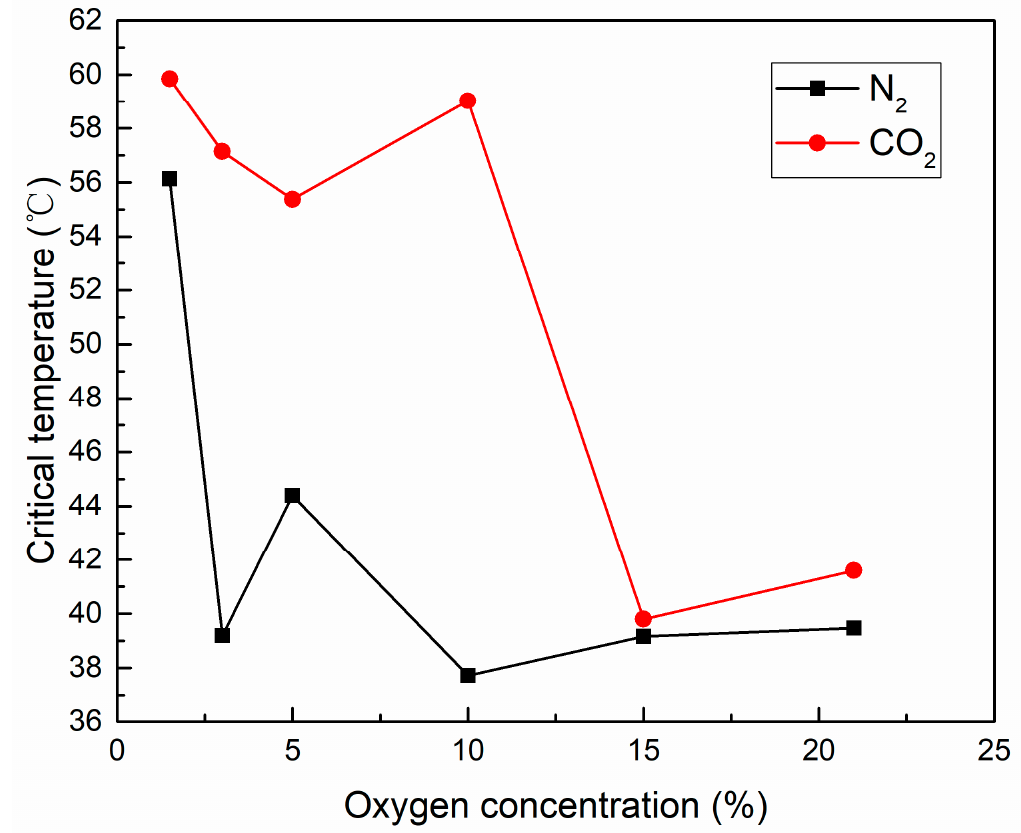
Figure 6. Critical temperatures of coal sample in the N 2 and CO 2 atmospheres.